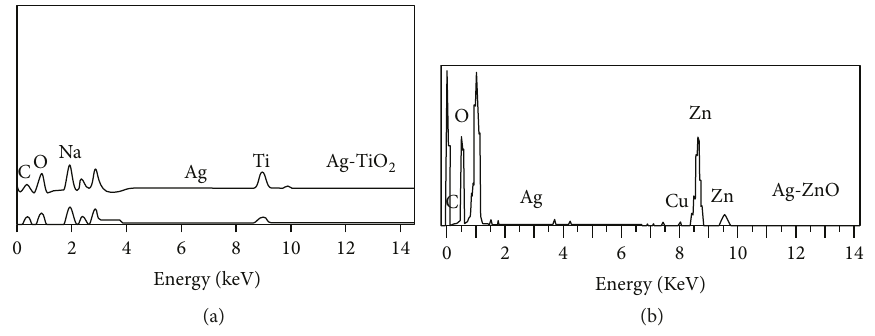
Figure 4: EDX spectrum of (a) Ag-TiO